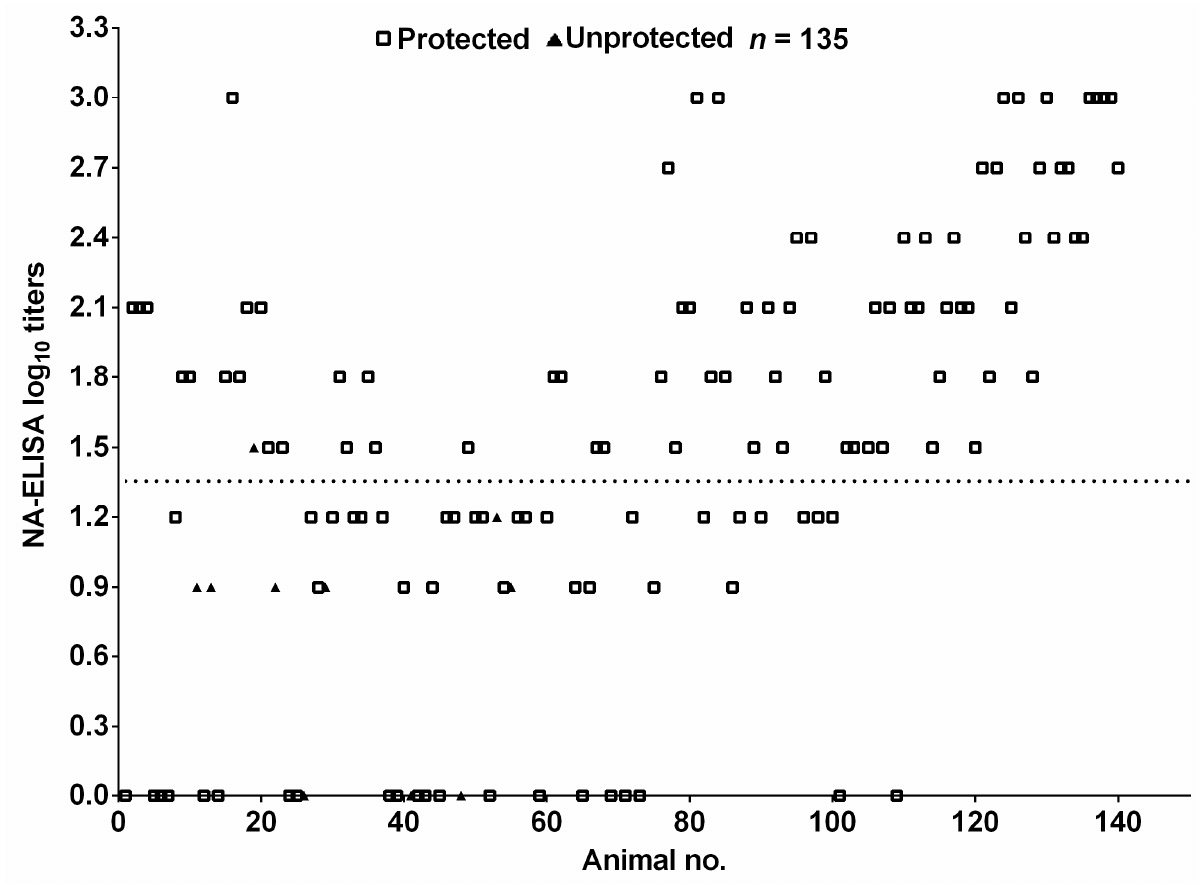
Figure 5. The relationship between NA-ELISA titers of vaccinated pigs and clinical protection against challenge with FMDV serotype O. Dispersion of individual values for protected pigs (open squares) and unprotected pigs (filled triangles). The dotted lines represent the cutoff value of NA-ELISA and n , number of pig sera tested.